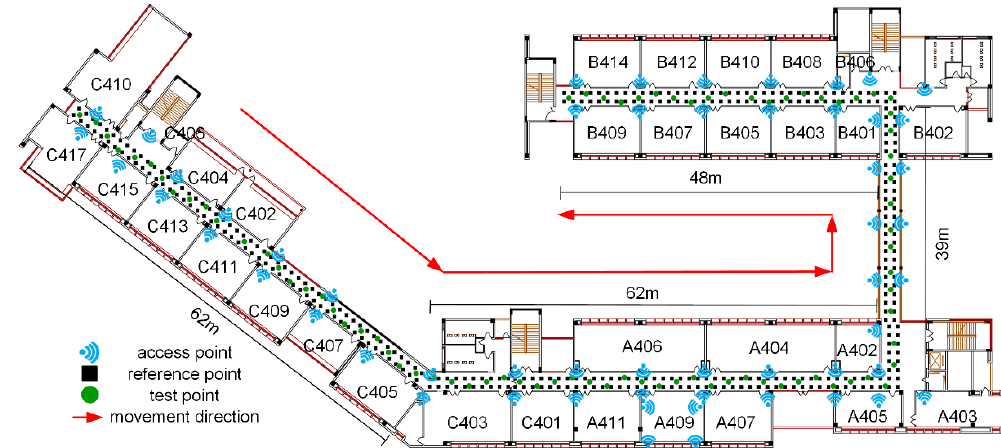
Figure 6. The layout of experimental testbed, where blue signal symbol denotes WiFi access point, solid black rectangle refers to reference point, solid green dot is test point, and the red arrow shows movement direction.